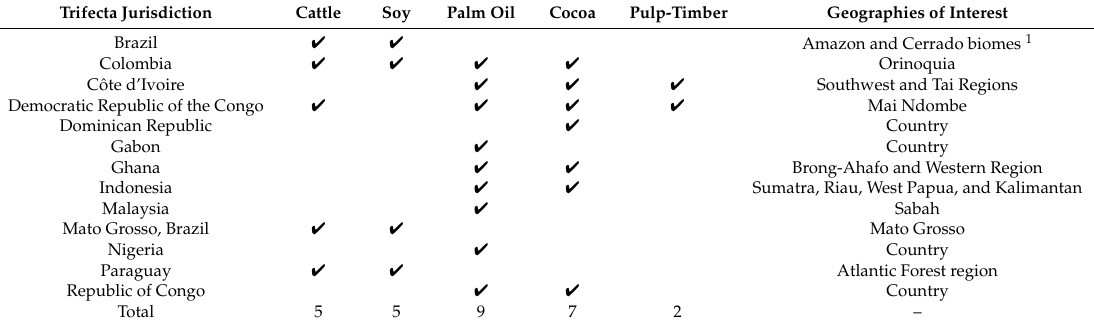
Table 1. All trifecta jurisdictions, including commodities of focus and geographies of